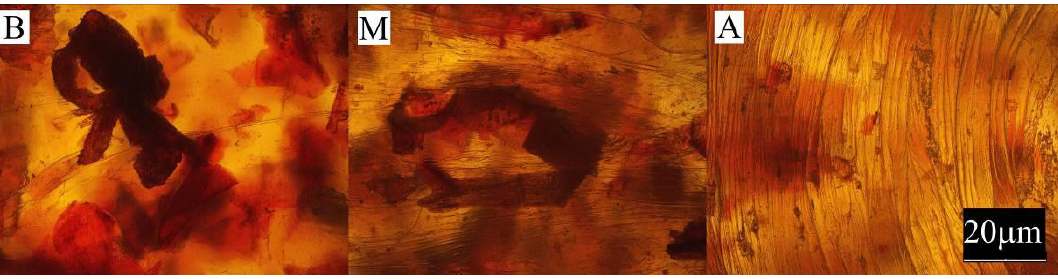
Figure 12. Appearance of the unfilled polyethylene moulding at measuring point A (the position of the point is marked in Figure